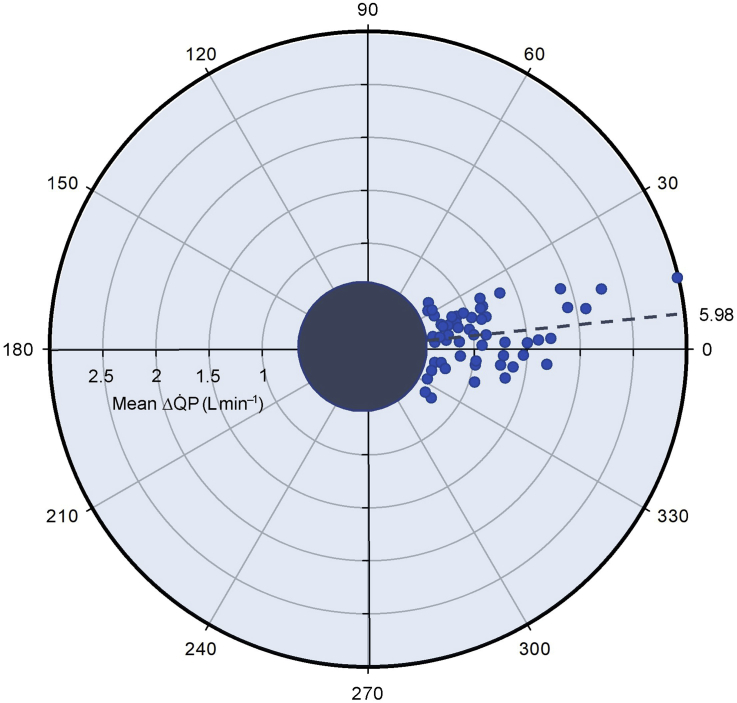
Half-circle polar-plot analysis of Q˙ISTvsQ˙T throughout the protocol, with an exclusion zone of 15% mean cardiac output (0.67 L min−1). Mean angular bias=5.98° (radial limits, ±30.2°). Data points located within ±30° limits were considered concordant (92.3%). Data points distributed near the polar axis (0°) indicate good trending.